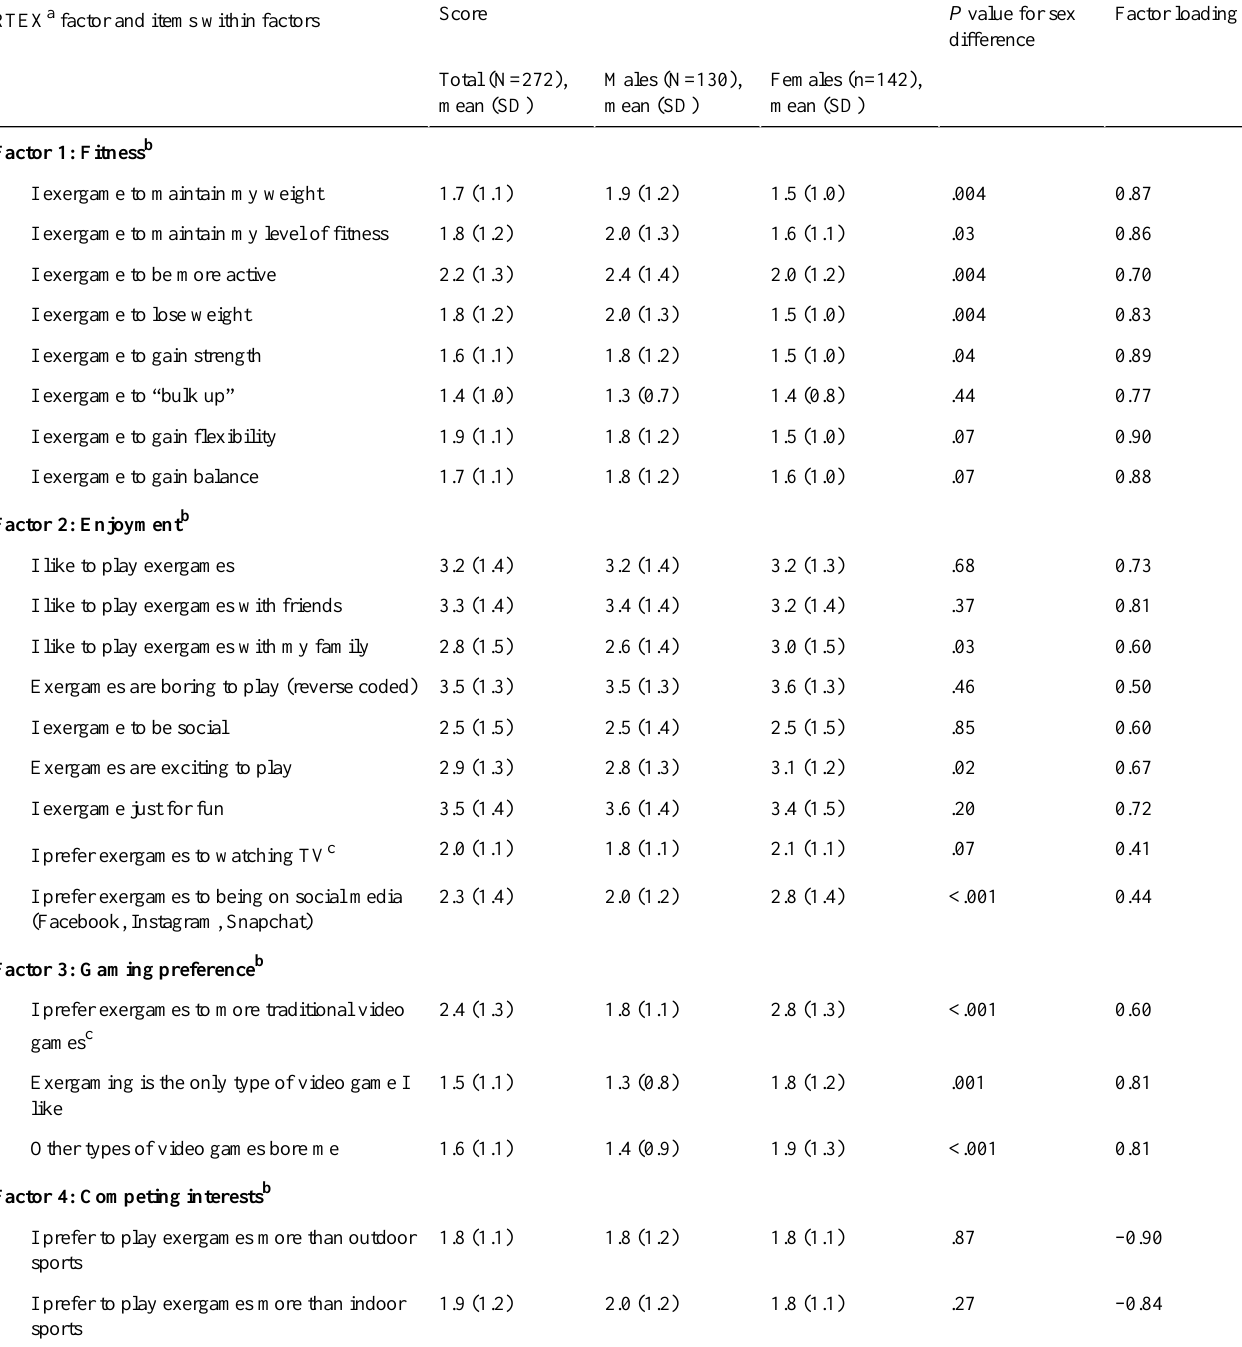
Table 2. Scores by sex and factor loadings of items retained in each RTEX factor (Study 1, NDIT 2017-2019).